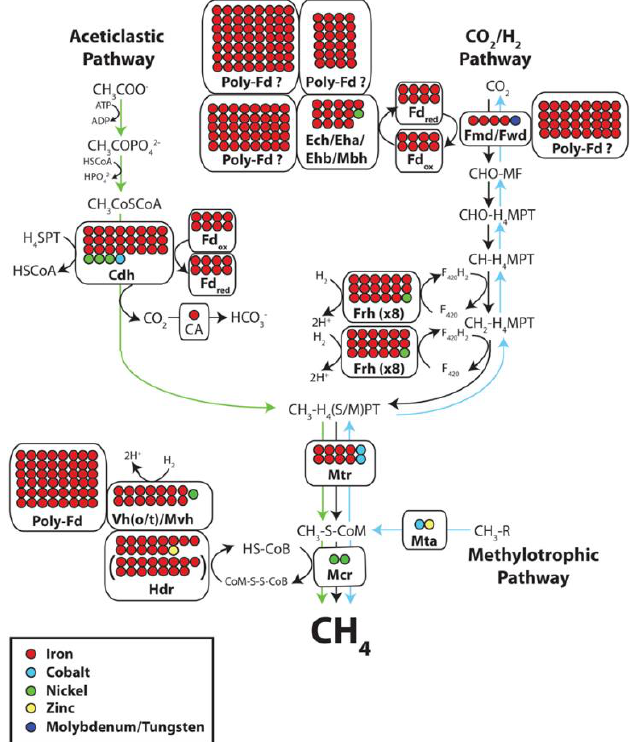
Figure 1. The three different pathways of producing methane, including the metal content of the enzymes in all the three pathways [35]; each trace metal is represented with different colored circles as shown in the legend. The abundance of red circles indicate that Fe is the most abundant metal followed by Ni and Co and traces of other metals as indicated. Reproduced with